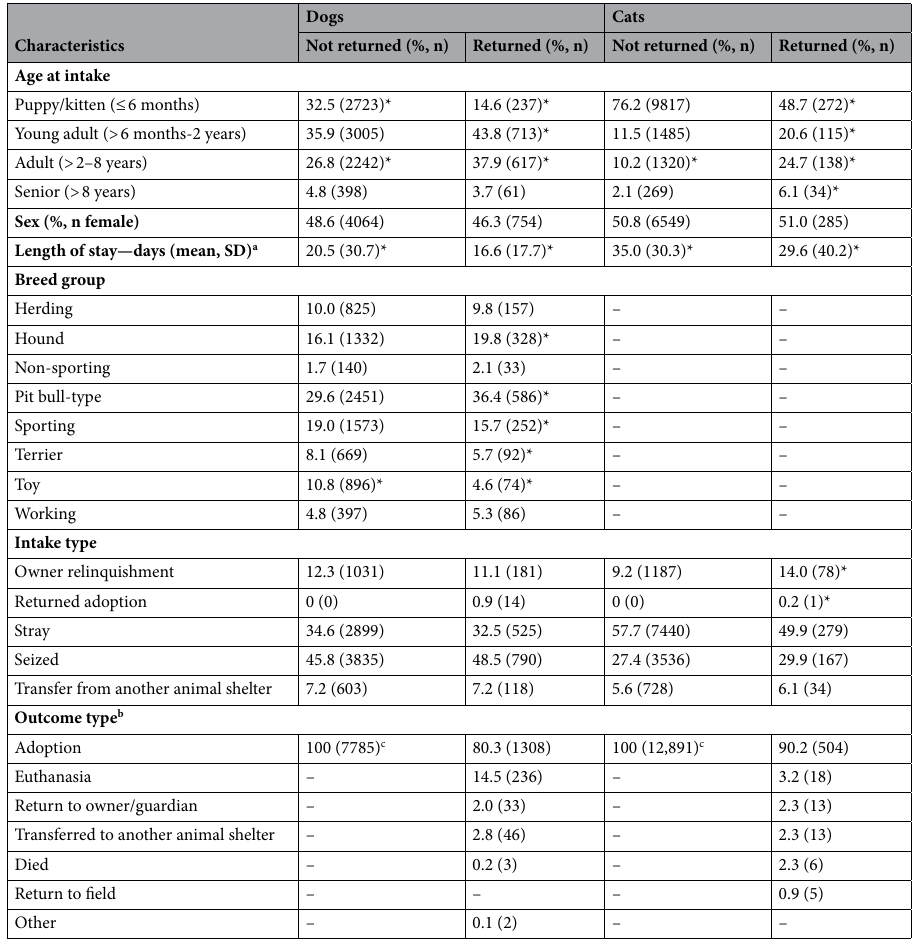
Table 1. Descriptive characteristics of animals adopted between 2015 and 2019 ( n = 23 945). Table shows the breakdown (%) of non-returned or returned animals within each characteristic. *Indicates there was a statistically significant difference between returned and non-returned animals based on Pearson’s Chi Square test or independent t-tests for length of stay. a Reflects initial length of stay (prior to return) for returned animals. b Reflects the most recent outcome for animals that were returned multiple times. c Only animals that were adopted at least once were included in this